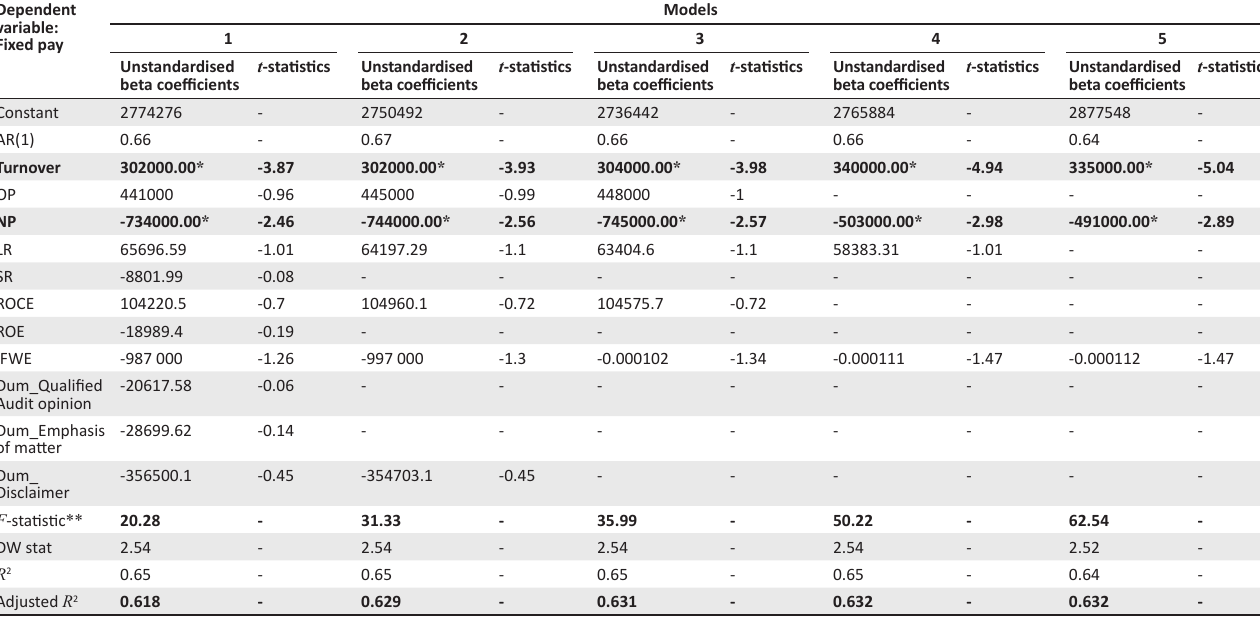
TABLE 7: Regression model: Fixed pay and company performance measures.